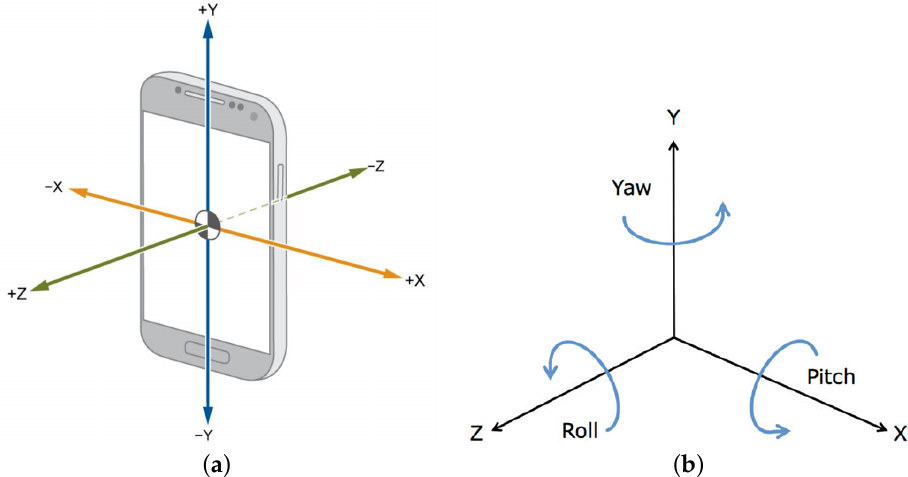
Figure 1. ( a ) Inertial frame orientation of the triaxial IMU in the smartphone; ( b ) Earth-fixed refer- ence